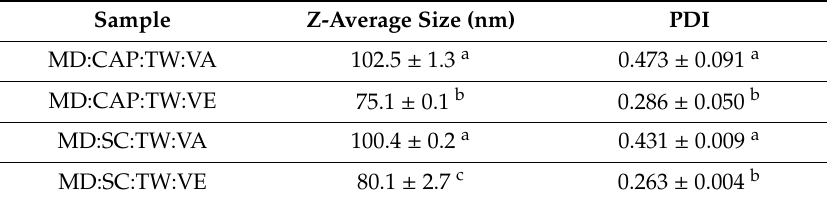
Table 1. Mean particle size and polydispersity index of Vitamin A (VA) and E (VE) nanoemulsion based on maltodextrin in combination with Capsul ® (CAP) or sodium caseinate (SC) and Tween 80 (TW).